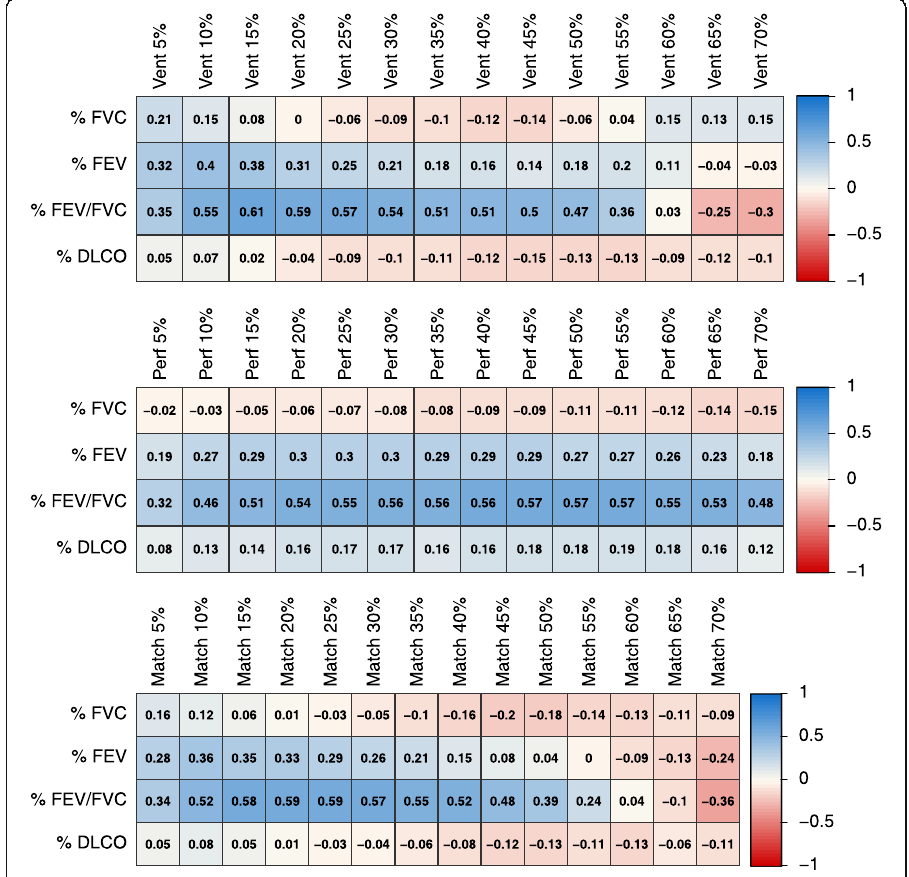
Fig. 2 Correlogram of baseline volumes vs. baseline